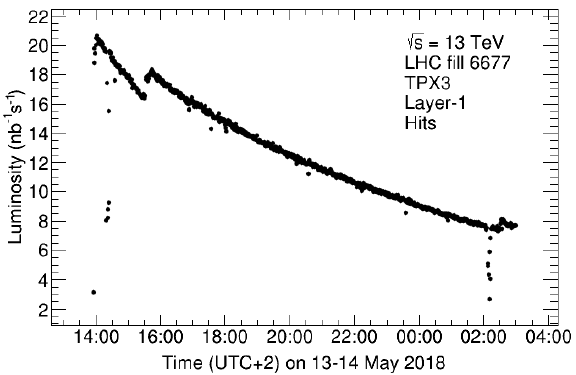
Figure 60. Time history of the TPX3 luminosity, as seen by TPX3 layer 1 using hit-counting in LHC fill 6677. The small dips, visible as variations from the descending curve, correspond to the times when the LHC operators performed small-amplitude beam-separation scans to optimize or increase the luminosity. A larger beam adjustment took place at about 15:30 (UTC+2). LHC emittance scans were performed at the beginning 14:30 (UTC+2) and at the end 2:10 (UTC+2) of the fill. The approximate normalization between hit rate and luminosity is based on the peak instantaneous luminosity [25]. Taken from Ref.